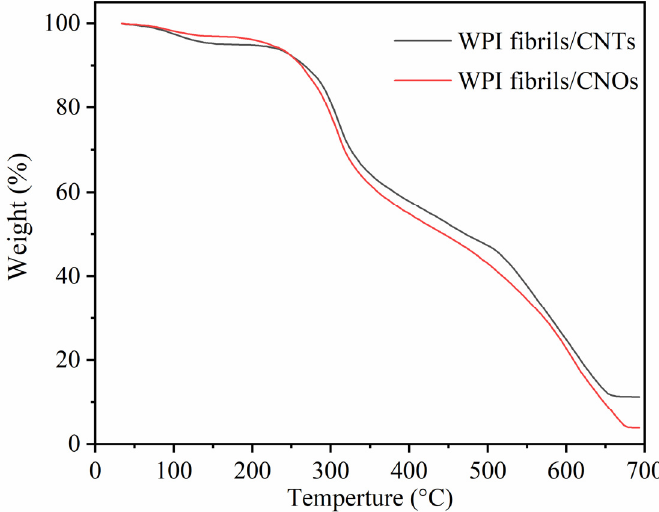
Figure 8. TG curves of WPI fibril–CNTs (or CNOs).